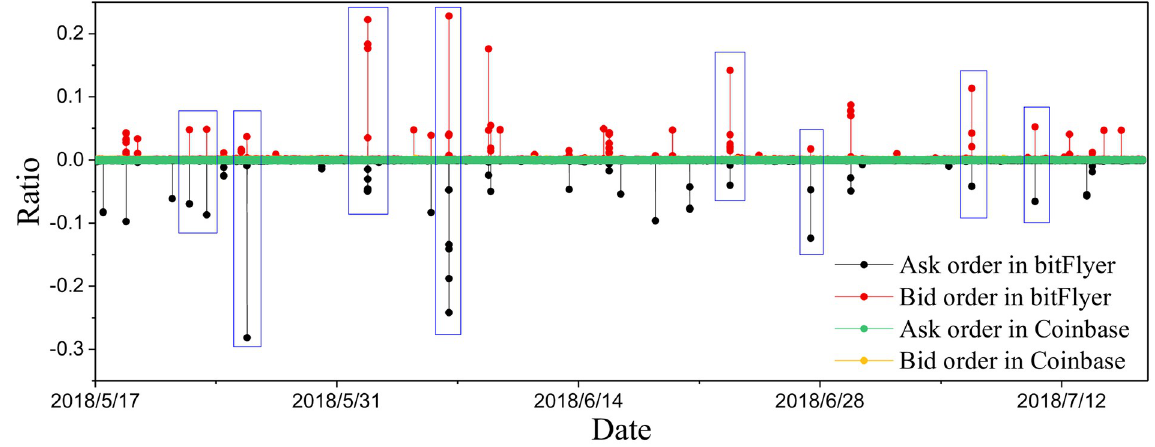
Fig 4. The values ratio a and ratio b in bitFlyer and Coinbase, sampled from May 17, 2018 to July 16, 2018.